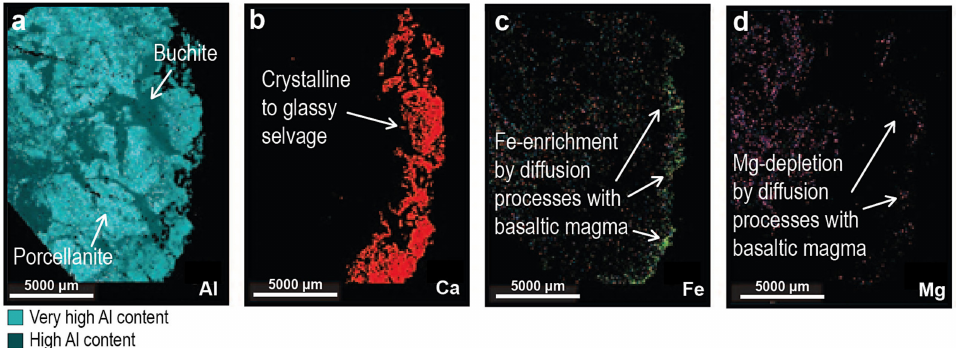
Figure 5. QEMSCAN TM element maps showing relative element concentrations ( a ) Al, ( b ) Ca, ( c ) Fe, and ( d ) Mg colour variations across the mapped region of B1 shown in Figure 5.